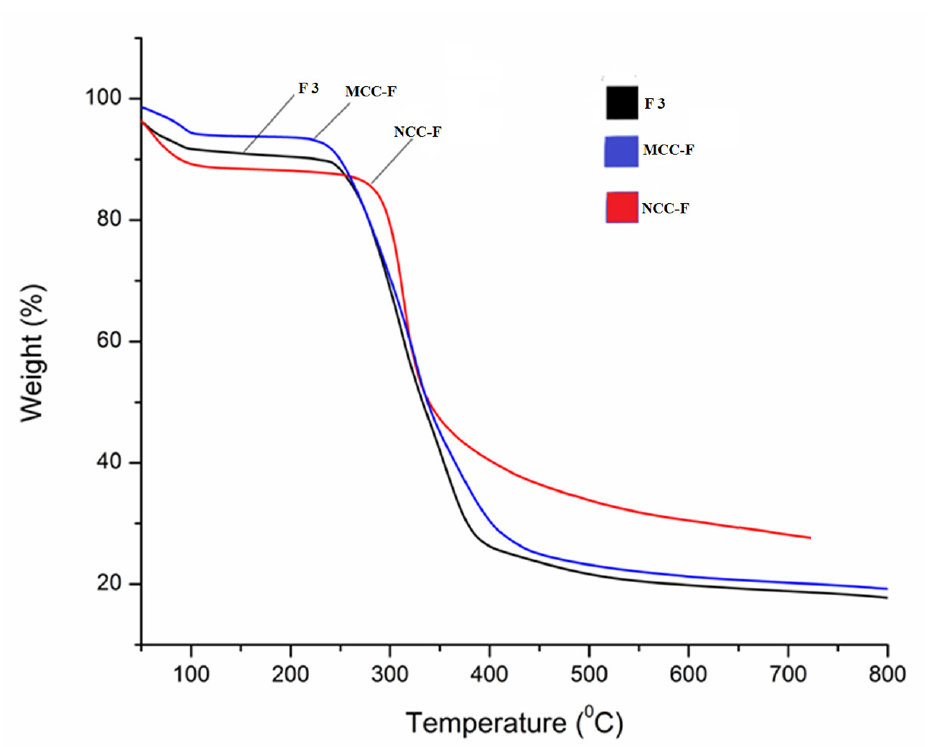
FIGURE 4 - TGA thermo gram of HPMC, MCC-F and NCC-F formulation.